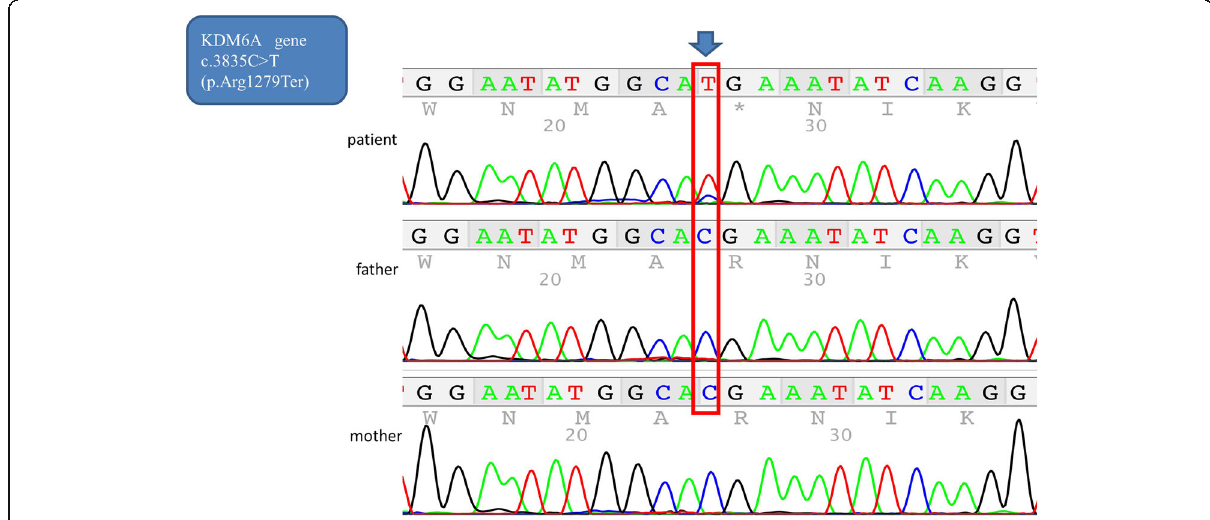
Fig. 5 Sequencing analysis of KDM6A. KDM6A sequencing identified a de novo pathogenic heterozygous nonsense mutation in exon 29; c. 3835C>T (p. Arg1279Ter)